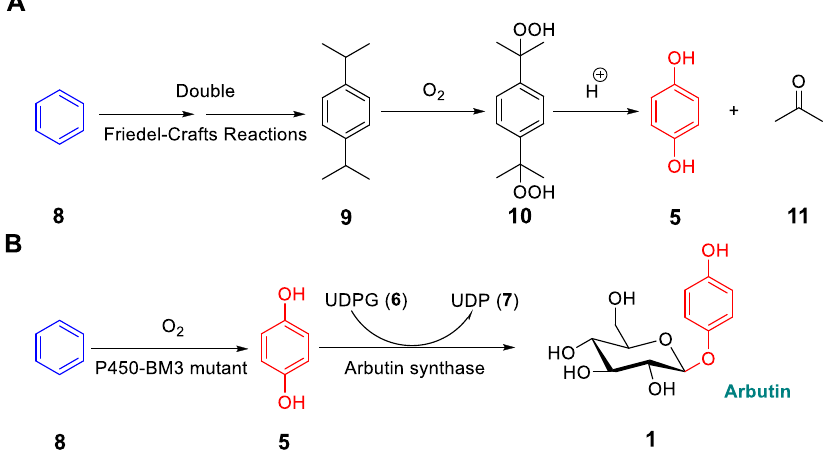
Figure 4. Synthesis of hydroquinone (HQ) from benzene by the conventional chemical route ( A ), and biocatalytic synthesis of arbutin from benzene in a one-pot cascade using designed E. coli cells ( B ). Figure adapted with permission from [36]. Copyright 2018 Wiley-VCH.